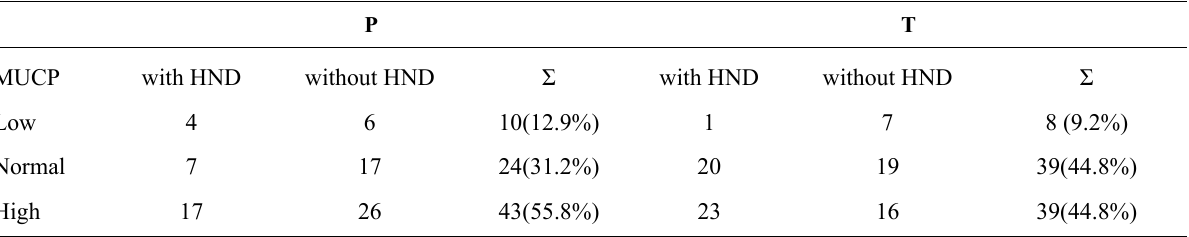
Table 4: Comparison of the maximal urethral closure pressure (MUCP) with the expected value for age in each DO group (women with or without a history of neurological disease